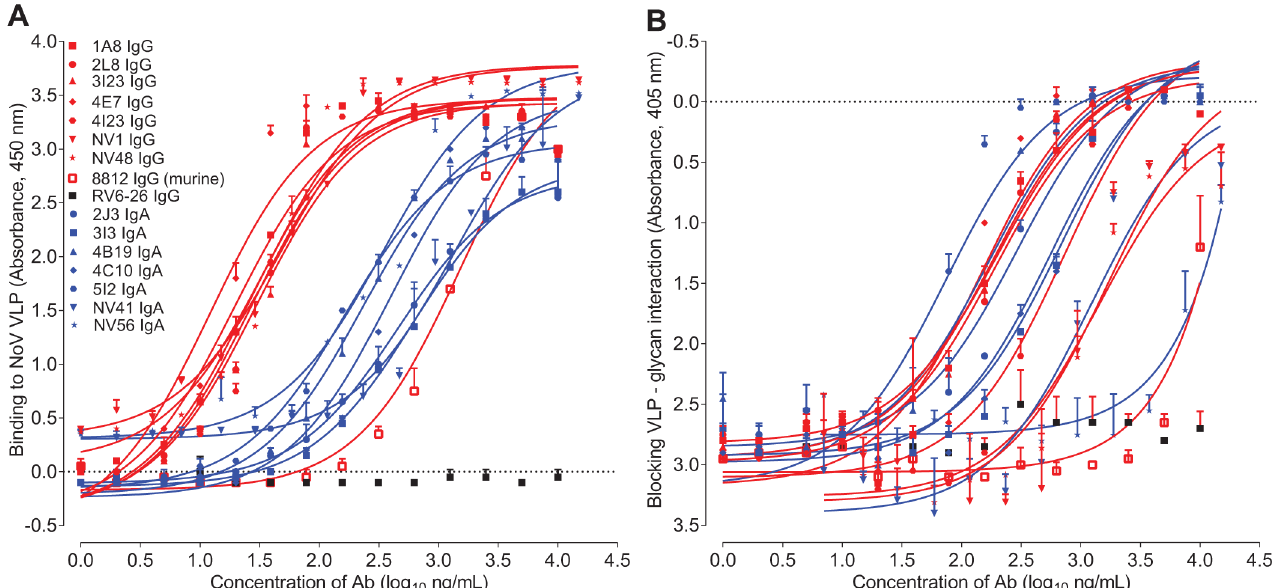
Fig 2. Binding and blocking characteristics of purified monoclonal antibodies. Purified IgG (red) or IgA (blue) antibodies were tested for binding to NV VLP in ELISA (A) or for blocking VLP — glycan interaction (B). Each of the IgG antibodies bound to VLPs with lower EC 50 values than IgA antibodies, while in contrast the concentrations needed for blocking were similar for IgG and IgA. The blocking of murine mAb 8812 is shown in black.